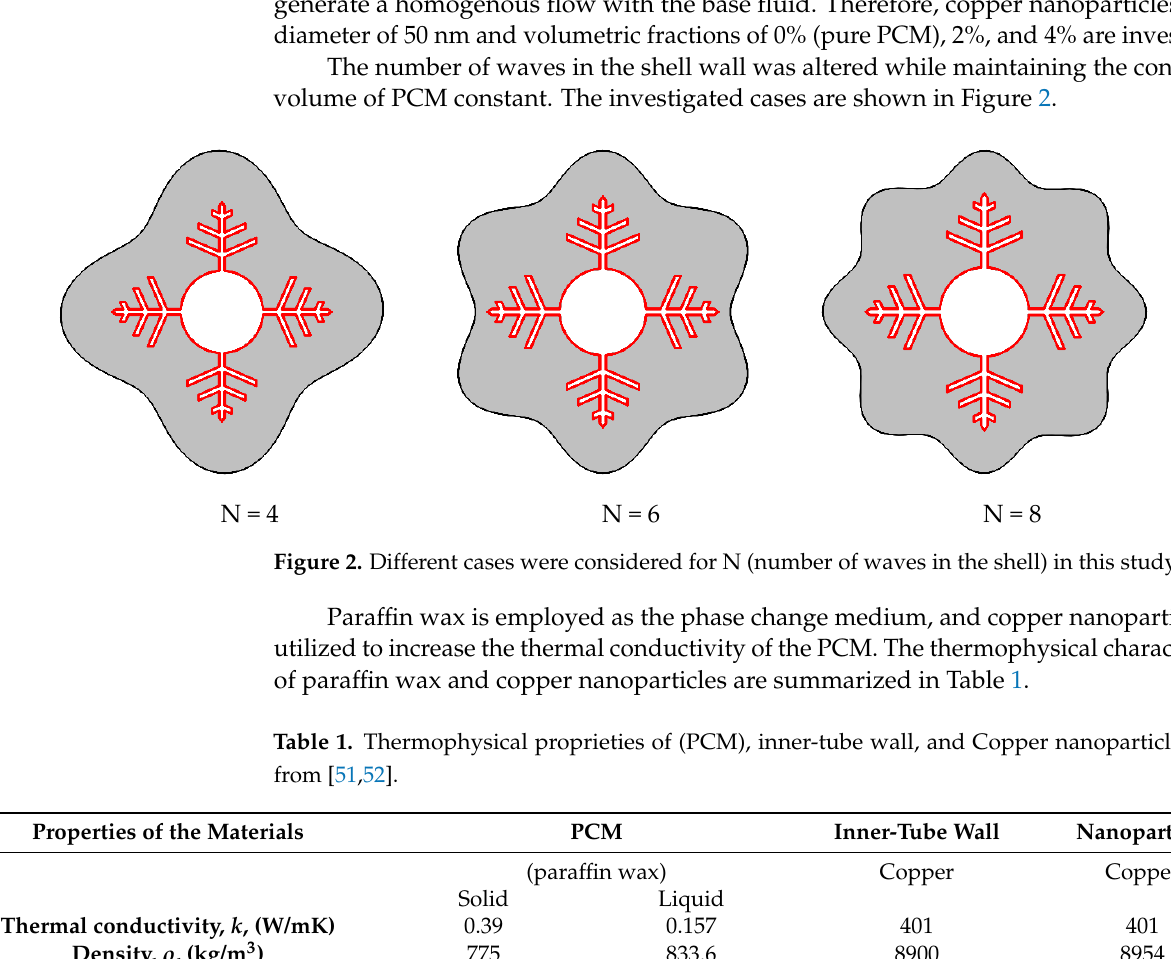
Figure 1. ( A ) Three-dimensional model of the shell and tube TEs with embedded fins; ( B ) A two- dimensional illustration of the studied model with boundary conditions; ( C ) A mesh sample; ( D ) fins dimensions.